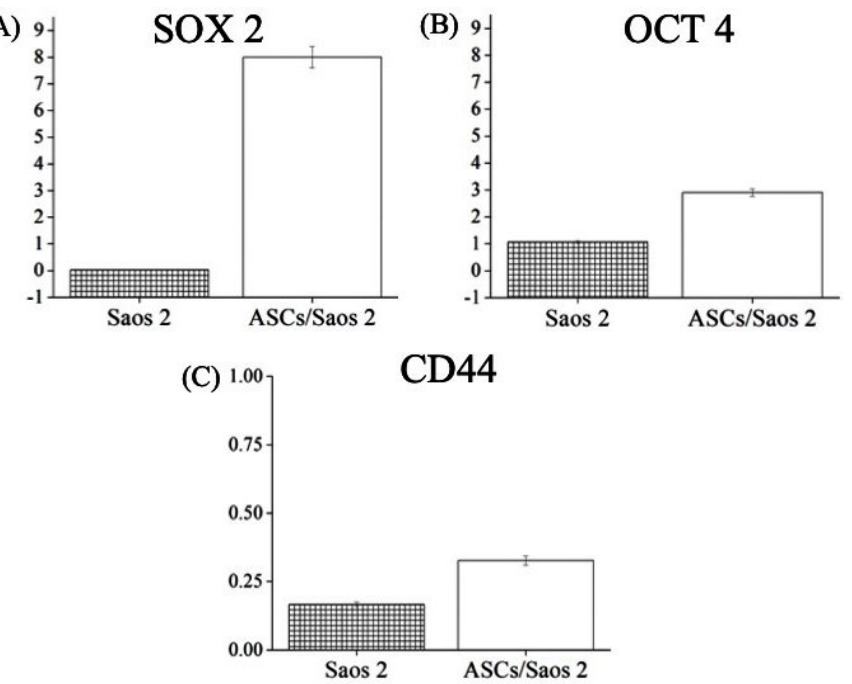
Figure 6. Expression of genes associated with chemoresistance, including ( A ) SOX 2, ( B ) OCT 4, and ( C ) CD44, in cells of homotypic (Saos 2) and heterotypic tumorspheres after doxorubicin treatment.